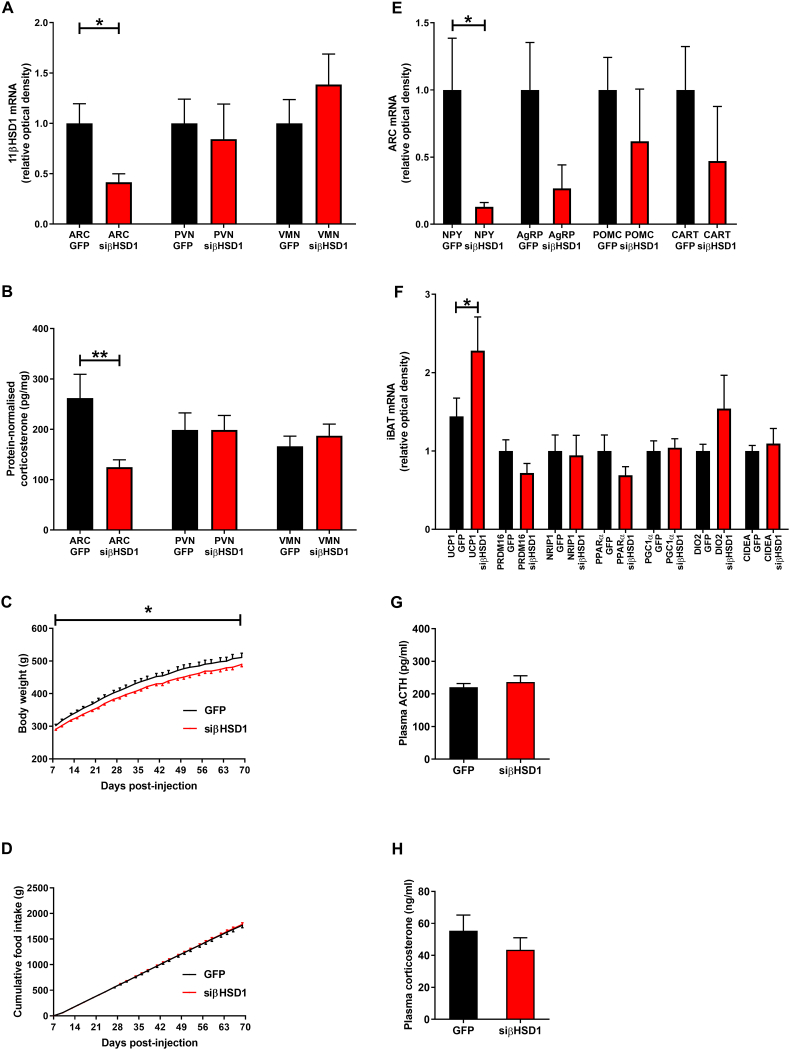
Decreased corticosterone in the arcuate nucleus of adult male rats is associated with attenuated body weight gain. A: Bilateral injection of small interfering rAAV specific for 11βHSD1 (rAAV-si11βHSD1) into the arcuate nucleus (ARC) results in a significant decrease in 11βHSD1 mRNA expression within the ARC but does not affect 11βHSD1 expression in the paraventricular nucleus (PVN) or ventromedial nucleus (VMN); GFP: n = 3, si11βHSD1: n = 3; ∗p < 0.05 (Mann–Whitney test). B: Bilateral injection of rAAV-si11βHSD1 into the ARC results in a significant reduction in corticosterone levels within the ARC but does not affect corticosterone levels within the PVN or VMN; GFP: n = 9, si11βHSD1: n = 10; ∗∗p = 0.01 (unpaired t-test). C: Reduced ARC corticosterone is associated with lower body weight compared to controls; GFP: n = 11, si11βHSD1: n = 10; ∗p < 0.05 (generalized estimating equation, GEE). D: Reduced ARC corticosterone does not affect food intake; GFP: n = 11, si11βHSD1: n = 10 (GEE). E: Reduced ARC corticosterone is associated with decreased expression of neuropeptide-Y (NPY) in the ARC but does not affect the expression of Agouti-related peptide (AgRP), cocaine- and amphetamine-regulated transcript (CART) or pro-opiomelanocortin (POMC); GFP: n = 3, si11βHSD1: n = 3; ∗p < 0.05 (Mann–Whitney test). F: Reduced ARC corticosterone is associated with increased interscapular brown adipose tissue (iBAT) uncoupling protein-1 (UCP1) expression; GFP: n = 11, si11βHSD1: n = 10; ∗p < 0.05 (unpaired t-test). There was no significant difference in mRNA expression of iBAT peptides associated with thermogenesis (i.e. PR domain containing 16 (PRDM16), nuclear receptor interacting protein 1 (NRIP1), peroxisome proliferator-activated receptor-α (PPARα), peroxisome proliferator-activated receptor gamma coactivator 1-α (PGC1α), iodothyronine deiodinase 2 (DIO2), and cell death activator (CIDEA)) in the group injected with rAAV-si11βHSD1 (siβHSD1) and the group injected with rAAV-GFP (GFP). G: Reduced ARC corticosterone does not affect plasma adrenocorticotrophic hormone (ACTH) levels; GFP: n = 11, si11βHSD1: n = 10 (unpaired t-test). H: Reduced ARC corticosterone does not affect plasma corticosterone levels; GFP: n = 9, si11βHSD1: n = 9; (unpaired t-test).